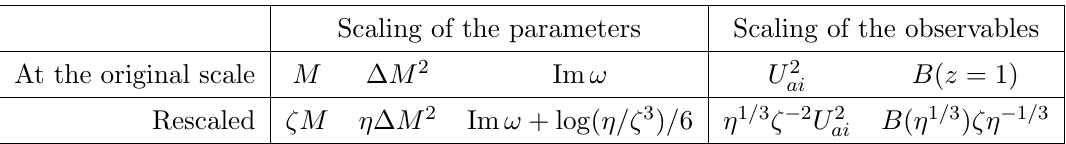
Table 2 . The approximate scaling of the observables (right column) under a change of the fun- damental parameters (left column). The Im(cid:10) is chosen such that the ratio of the oscillation and equilibration time scales remains constant. By (cid:12)nding a solution to the evolution equations B ( z ) for a particular choice of parameters, we can obtain the approximate baryon asymmetry for a class of parameter choices related by this